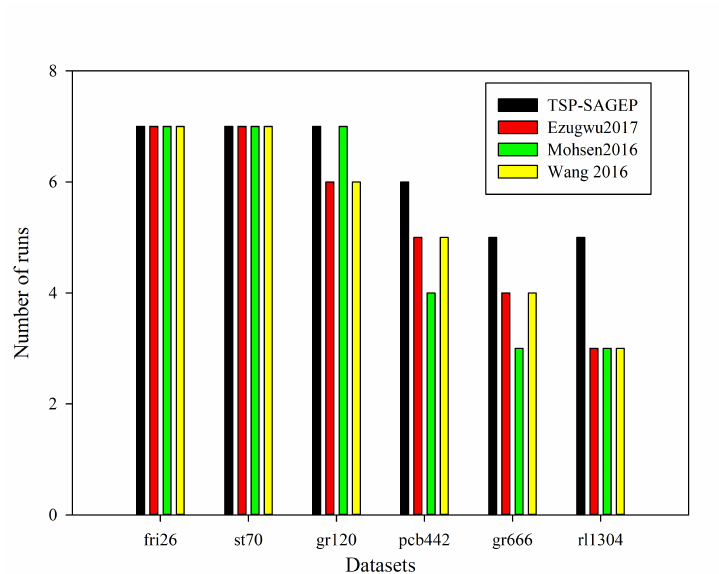
Figure 5. Comparison of the number of the best solutions obtained by four algorithms for six instances in all ten runs.